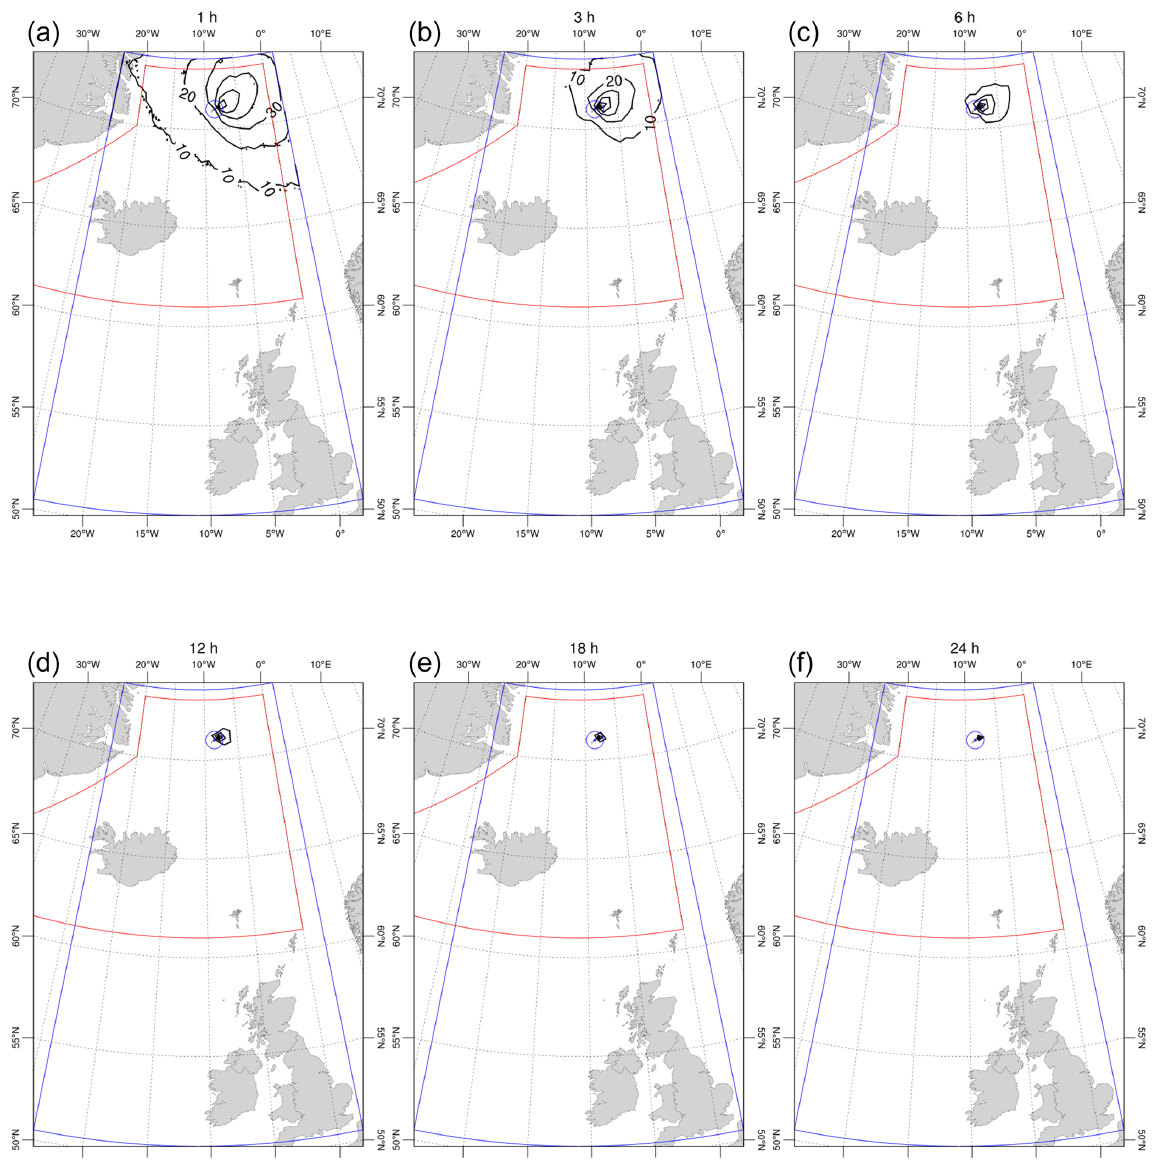
Figure D2. Persistence maps at FL250 (large class): the isolines show the probability of reaching or exceeding an ash concentration above 2mgm − 3 at FL250 at 1, 3, 6, 12, 18, and 24h during the eruption to up to 48h after its